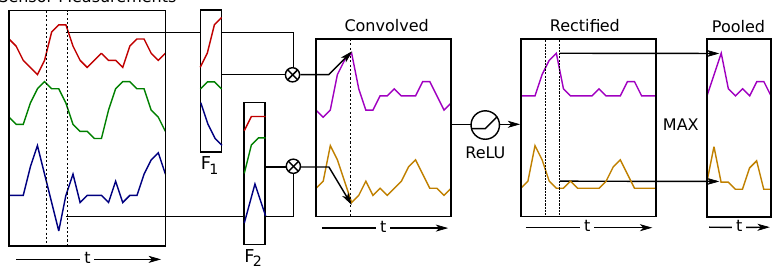
Figure 16. Example convolutional and pooling layer in the convolutional neural network. From